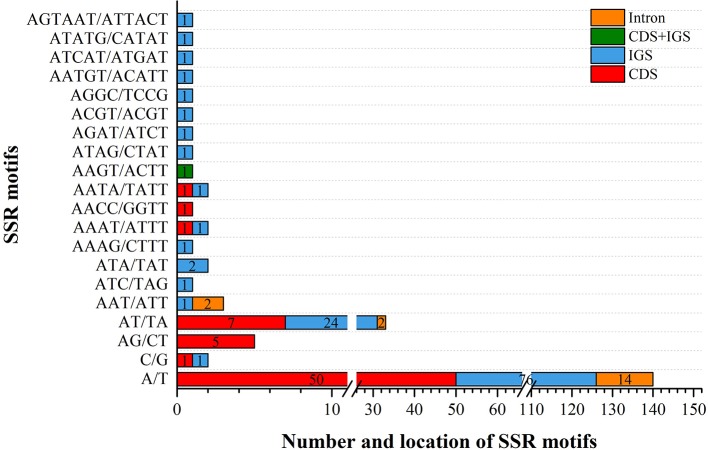
The types and distribution of SSRs along the chloroplast genome of V. sepium. Different locations, including CDS, IGS, CDS and IGS, and intron regions, are represented as colored boxes.